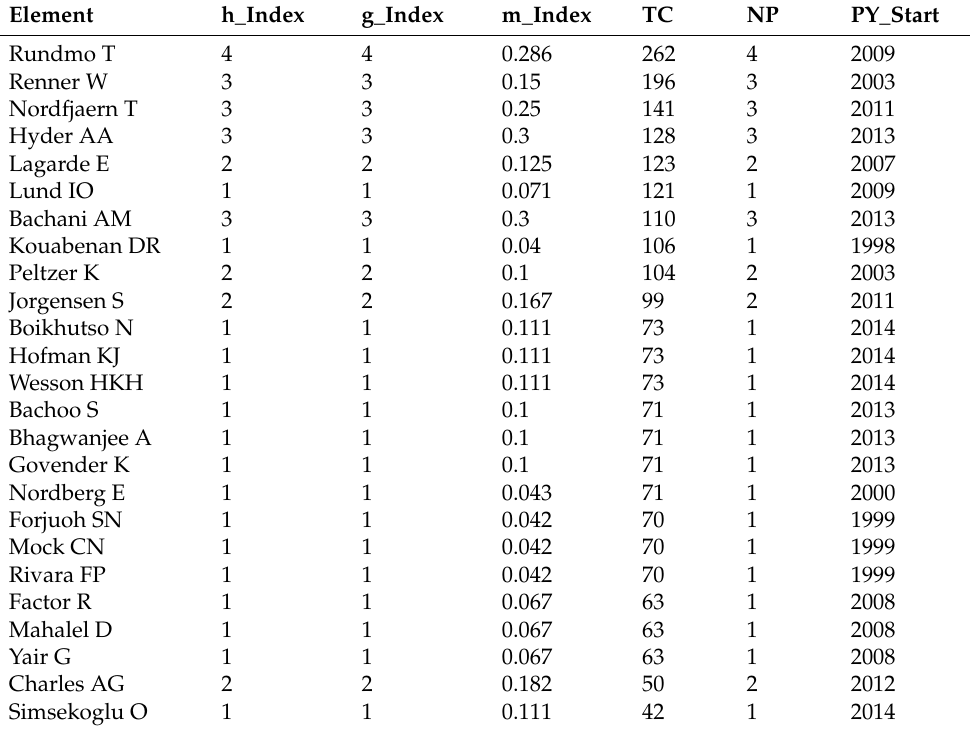
Table 3. Most influential